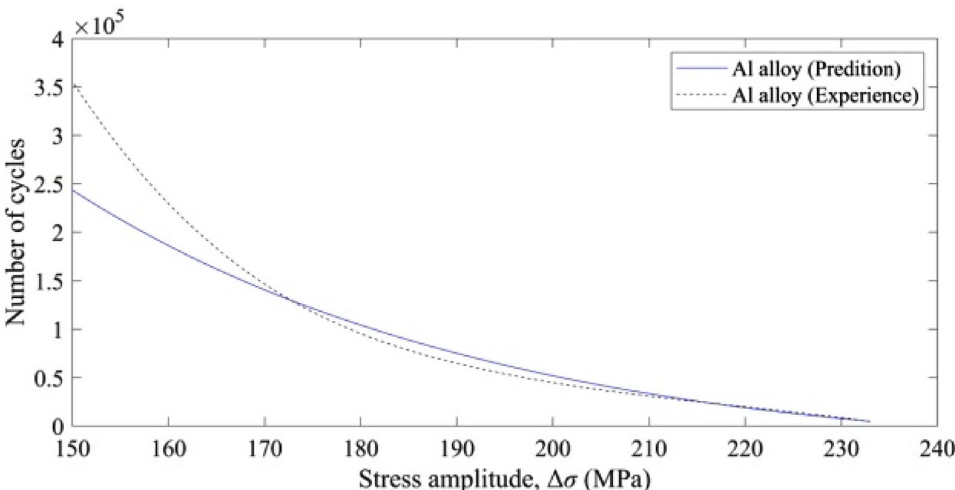
Figure 8 Comparison of experience data and fitting curve in Al